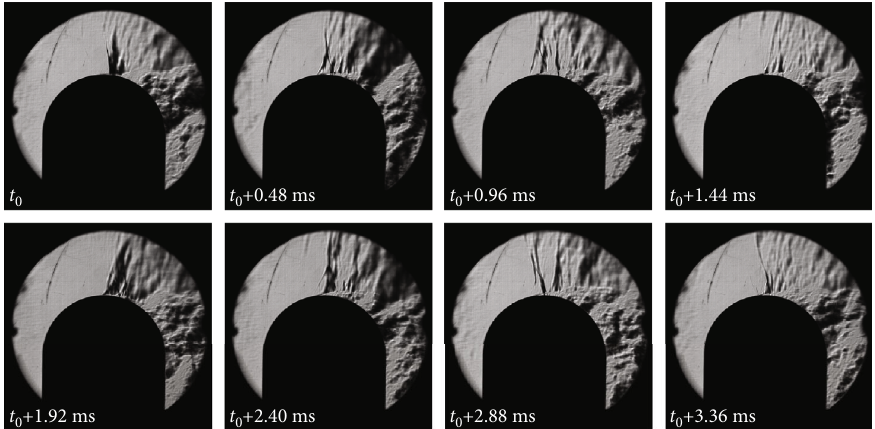
Figure 9: Schlieren images of the local shock from the side view ( Ma = 0 : 65